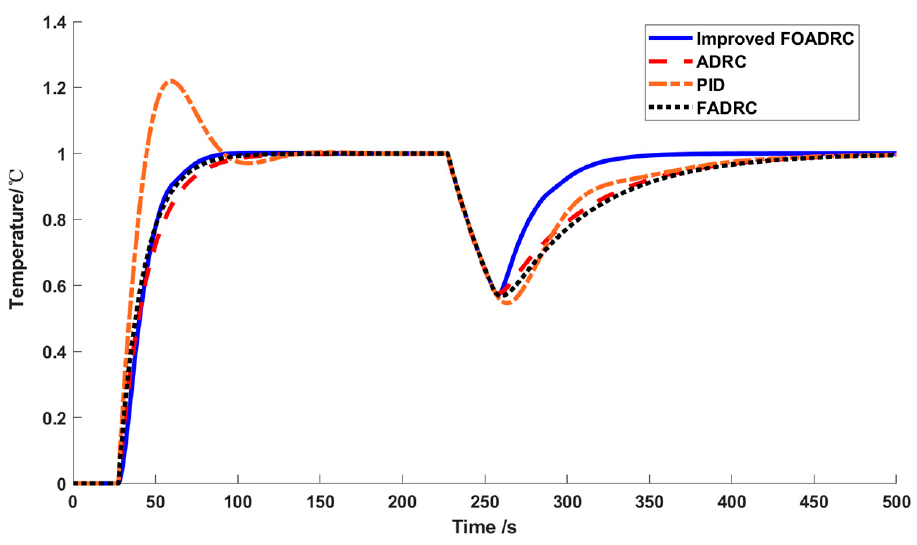
Figure 9. Response curve.